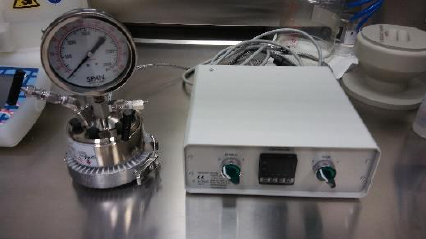
Figure 1. Hydrothermal growth set up with the stainless steel autoclave and temperature regulator.